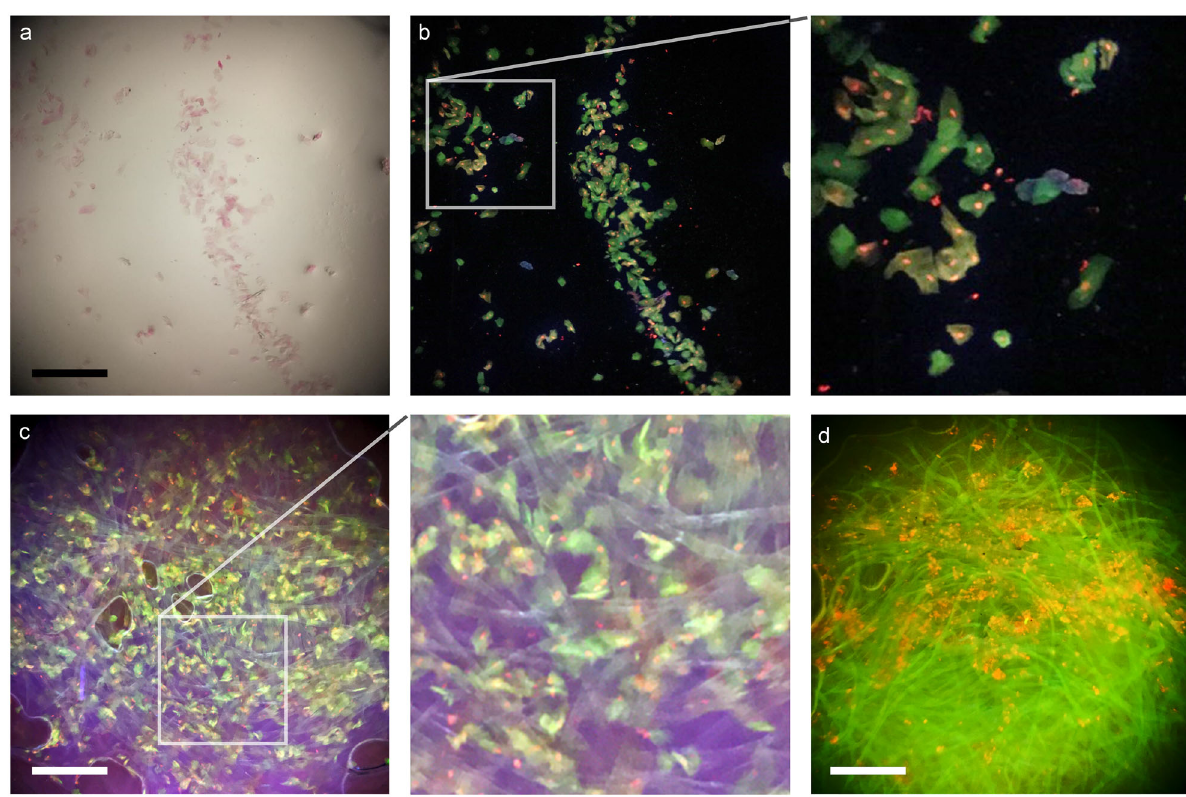
Fig. 8 Images of mucosal smear samples acquired with Pocket MUSE. A cheek swab sample was acquired by smearing the cells on the Pocket MUSE sample holder and the same region was imaged with ( a ) bright- fi eld mode and ( b ) MUSE fl uorescent mode. The sample was collected using a conventional cotton swab, stained in 10% v/v CytoStain with 0.05% w/v propidium iodide, and washed with tap water. A close-up view of the region labeled with the box (box size: 500 × 500 µ m 2 ) is shown on the right demonstrating good image quality even near the corner of the FOV. The cytoplasm is stained in green or yellow by CytoStain. Cell nuclei (within the cytoplasm) and bacteria (outside cytoplasm) are stained in red by propidium iodide. c MUSE fl uorescent images of a cotton swab tip containing a stained cheek swab sample. A close-up view of the region labeled with the box (box size: 500 × 500 µ m 2 ) is shown on the right showing cells attached to the cotton matrix without signi fi cant fl attening from the glass surface due to surface tension. d MUSE fl uorescent images of a cotton swab tip containing a healthy conjunctival (eyelid) swab sample stained with CytoStain and propidium iodide. The samples showed fewer cells, but more nucleic acid structures which are likely from conjunctival microorganisms. The cellulose matrices were rapidly stained in green due to the lack of viscous mucus. Scale bars: 300 µ